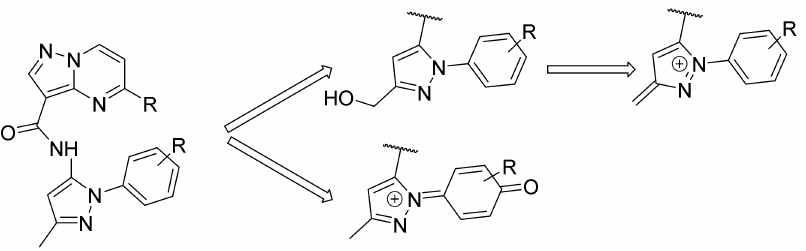
Figure 47. Schematic view of possible active metabolites formed in the 3-methyl- N -arylpyrazole core.